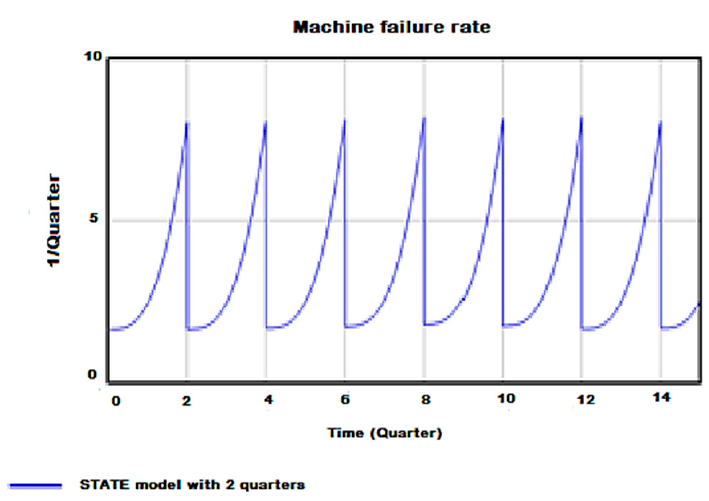
Figure 11. AS-IS failure rate diagram.